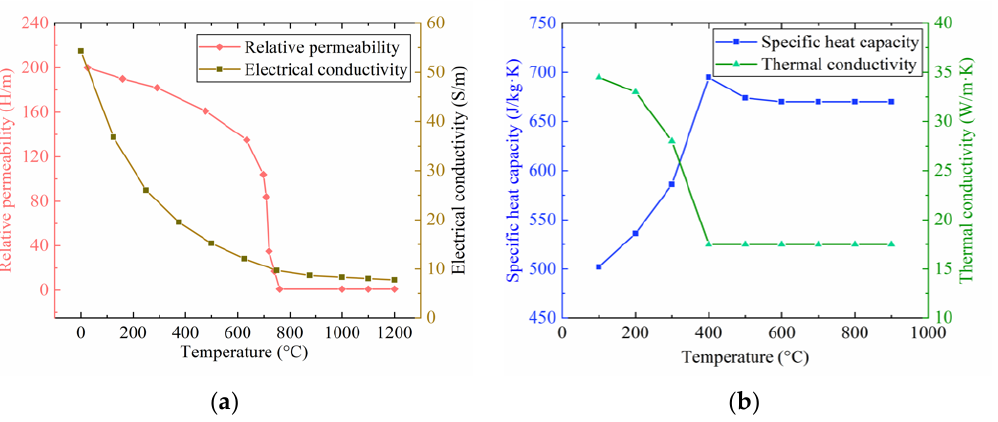
Figure 5. Parameter curves of the 20CrMnTi with temperature: ( a ) thermal parameters, ( b ) electrical parameters. Table 3. Chemical composition of 20CrMnTi (wt%).